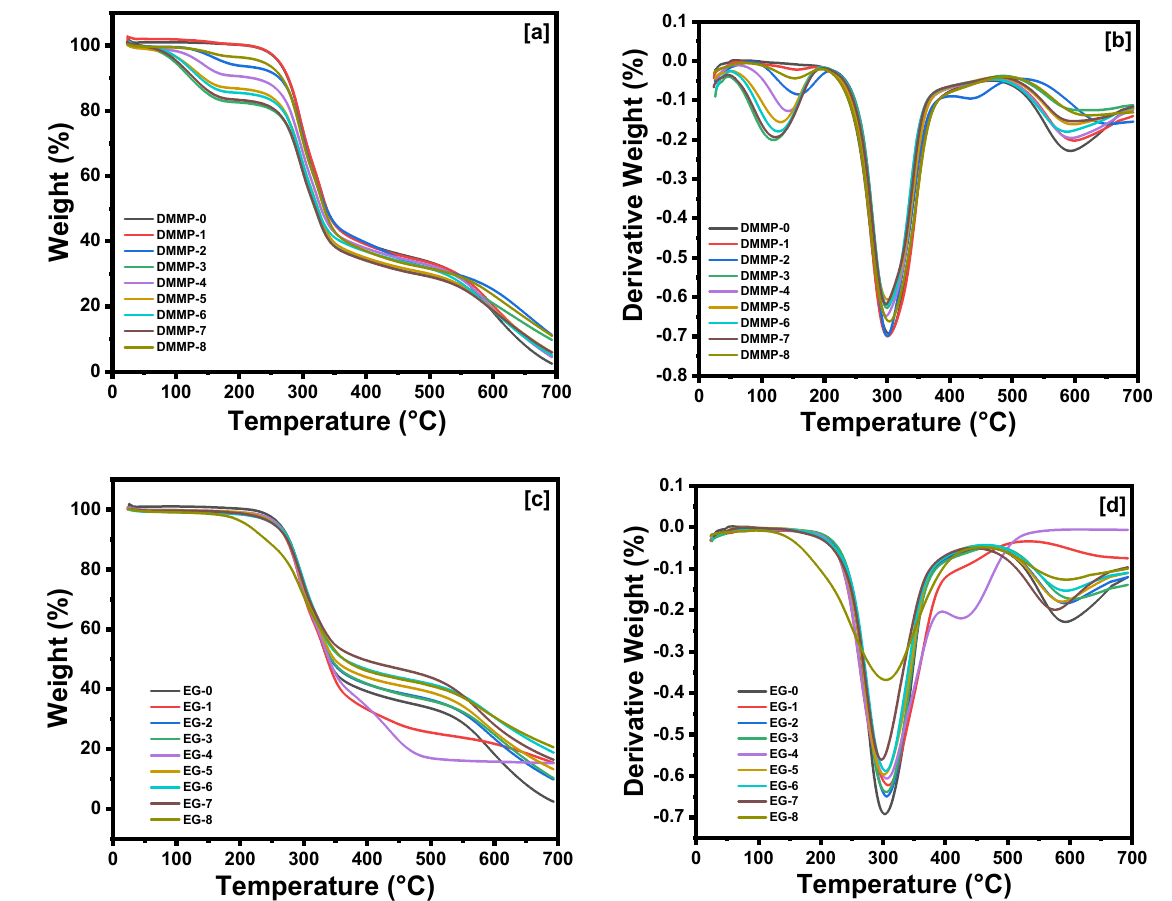
Figure 5. TGA and DTGA graphs for ( a , b ) DMMP and ( c , d ) EG. To test the effects of DMMP and EG on the flame retardancy of the sunflower-based PU foams, burning tests were performed to measure the burning times and weight losses. The horizontal burning test using the ASTM standard was adopted. The foams were firmly held and exposed to a burning source for 10 s. After that, the flame was removed, and the time required for the sample to extinguish the fire along with its weight loss was recorded. Based on that, the weight loss and burning time plots for all foams are demonstrated in Figure 6. The neat foam presented the highest weight loss of about 50% along with a burning time of around 80 s. After the addition of DMMP and EG, separately, there was a drastic diminishment in both the weight loss and burning time of the foams. In that sense, the optimum amount of DMMP added was 8 g (13.6 wt.%), which led to a weight loss of 1.06% and a burning time of 2 s. Likewise, the optimal amount of EG added was also 8 g (13.6 wt.%) as it displayed a weight loss of 1.65% and a burning time of 6 s. Further addition of FR led to a milder decrease in weight loss and burning time, which was not considerably better than the flame retardancy performance when smaller quantities of FRs were added. Hence, it has been noted that sunflower-based polyurethanes do not require a higher load of FRs to reach their optimal flame retardancy efficiency. Such an aspect is a good indication that these foams can be suitable for scaled